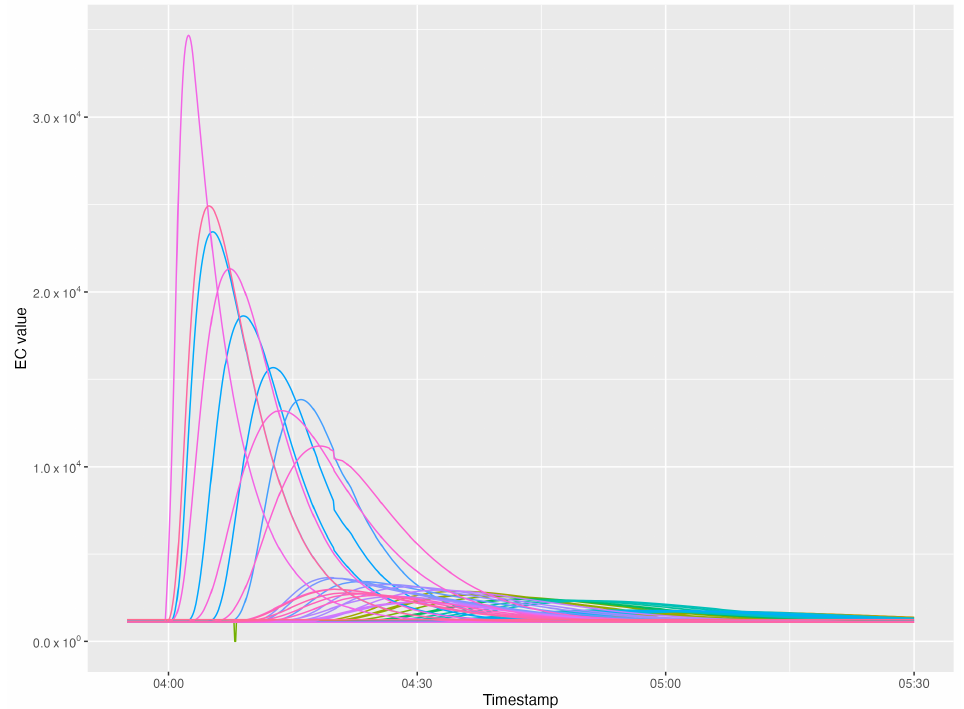
Figure 2. EC broadening and flattening caused by dispersion as seen at different measuring points, when 50 litres of sulphuric acid are discharged 81 manholes upstream from the sink point of the network shown in Figure 3 in low wastewater flow